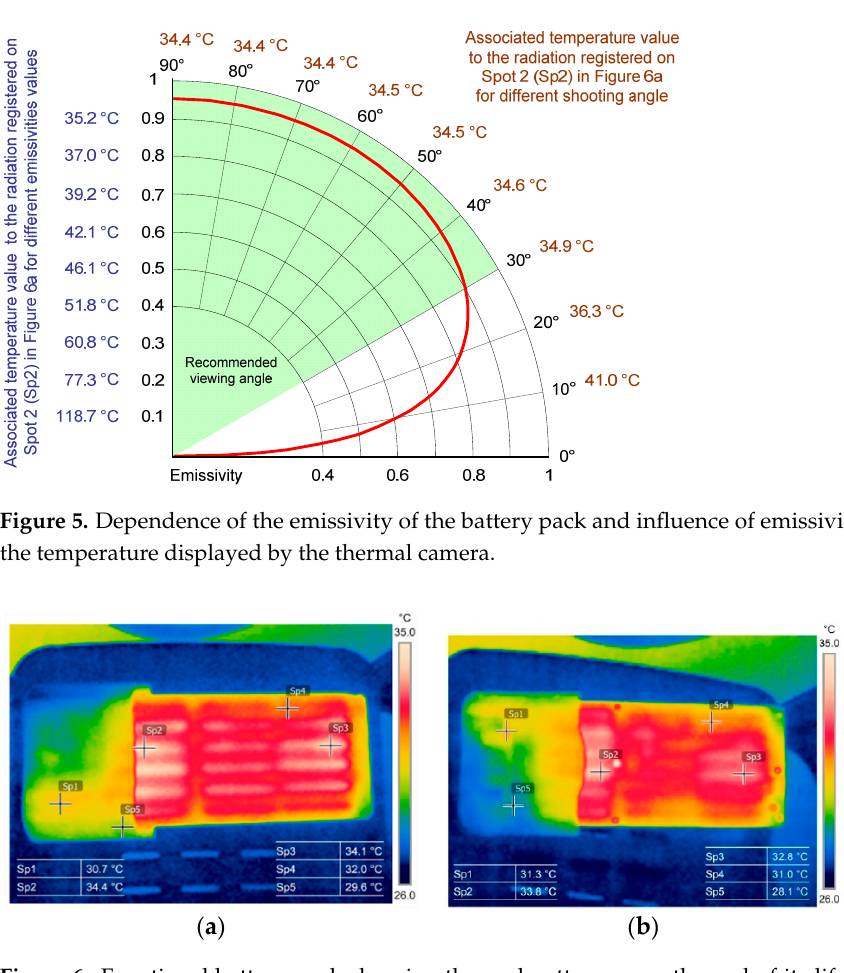
Figure 6. Functional battery pack charging thermal patterns near the end of its life, ( a ) top view ( b ) bottom.